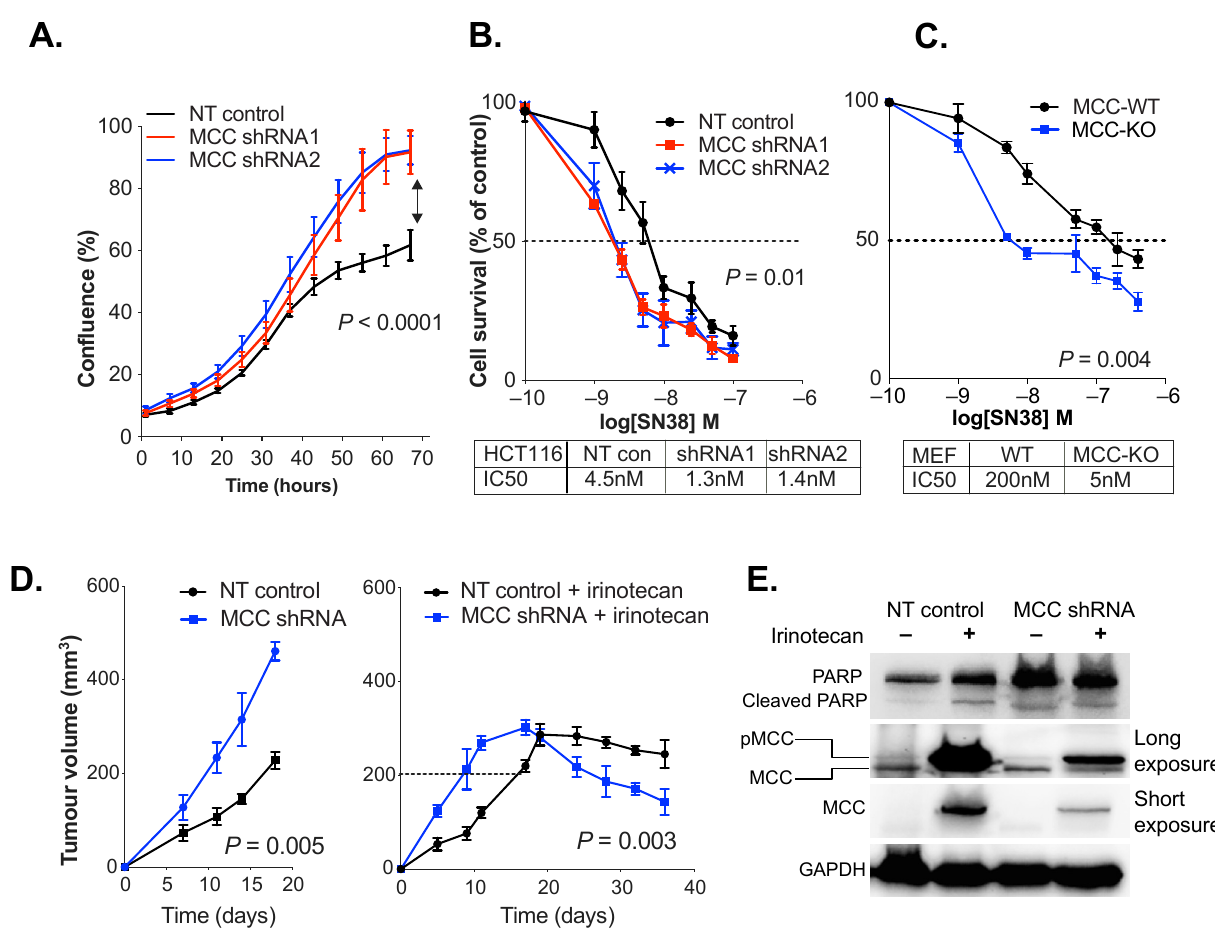
Figure 2. MCC deficiency increases DNA damage, PARP nuclear localization and cell death in response to SN38/irinotecan exposure. ( A ) MCC knockdown (shRNA1 and shRNA2) increases rate of HCT116 cell proliferation in vitro (IncuCyte). Statistical significance was determined using a two-way ordinary ANOVA. Error bars show mean ± SD of 3 replicates. ( B , C ) MCC knockdown or deletion sensitises HCT116 cells and MEFs to SN38 in vitro. Cells were treated with rising concentrations of SN38 (1 nM to 1 µ M), and harvested after 48 h. IC50 was extrapolated from log-dose vs. response curves using GraphPad Prism. Statistical significance was determined using a paired t -test. Error bars show mean ± SD of 5 replicates. ( D ) MCC -deficient tumors grow significantly faster and are more responsive to irinotecan treatment than MCC -expressing tumors. Athymic BALB/c nude mice were injected with non-targeted (NT) HCT116 control cells or MCC -shRNA2 cells. When tumors reached 200 mm 3 , half of the mice received 3 doses of 30 mg/kg irinotecan hydrochloride (right) on days 1, 5 and 10. Half of the mice received no treatment (left). Statistical significance was tested using two-way ANOVA (left panel) and a paired t -test (last four time points in right panel). Error bars show mean ± SEM. ( E ) Xenograft-harvested MCC -shRNA and NT tumors show increased MCC phosphorylation in response to irinotecan, and MCC -shRNA tumors show increased PARP expression regardless of treatment. Protein lysates were extracted by RIPA buffer and 30 µ g of protein per sample was analyzed. The Western blot film was developed at low exposure (2 s) and long exposure (120